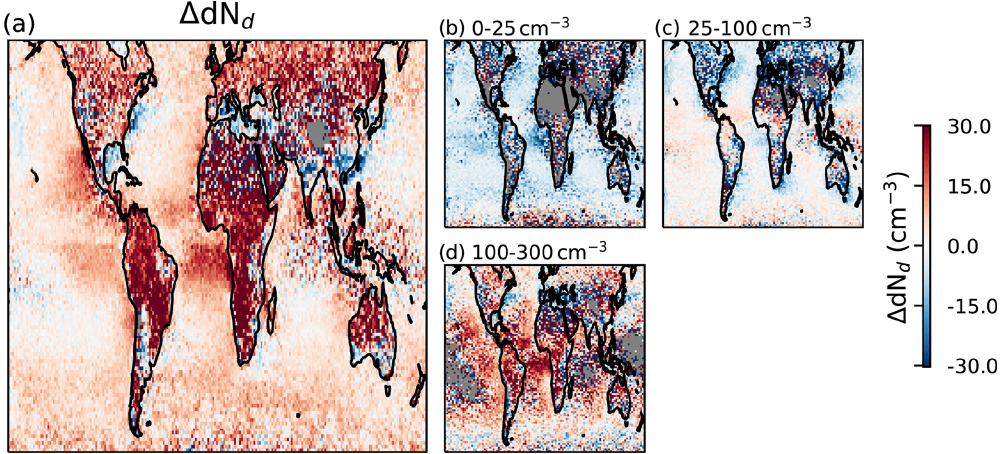
Figure 3. The same as Fig. 2 but showing the difference in N d evolution between clouds with an initial LWP higher and lower than 60gm − 2 . Panel (a) shows all data, while panels (b–d) show cases where the initial N d is restricted to the specified range. Note the larger fraction of missing data due to the more stringent sampling constraints on the N d